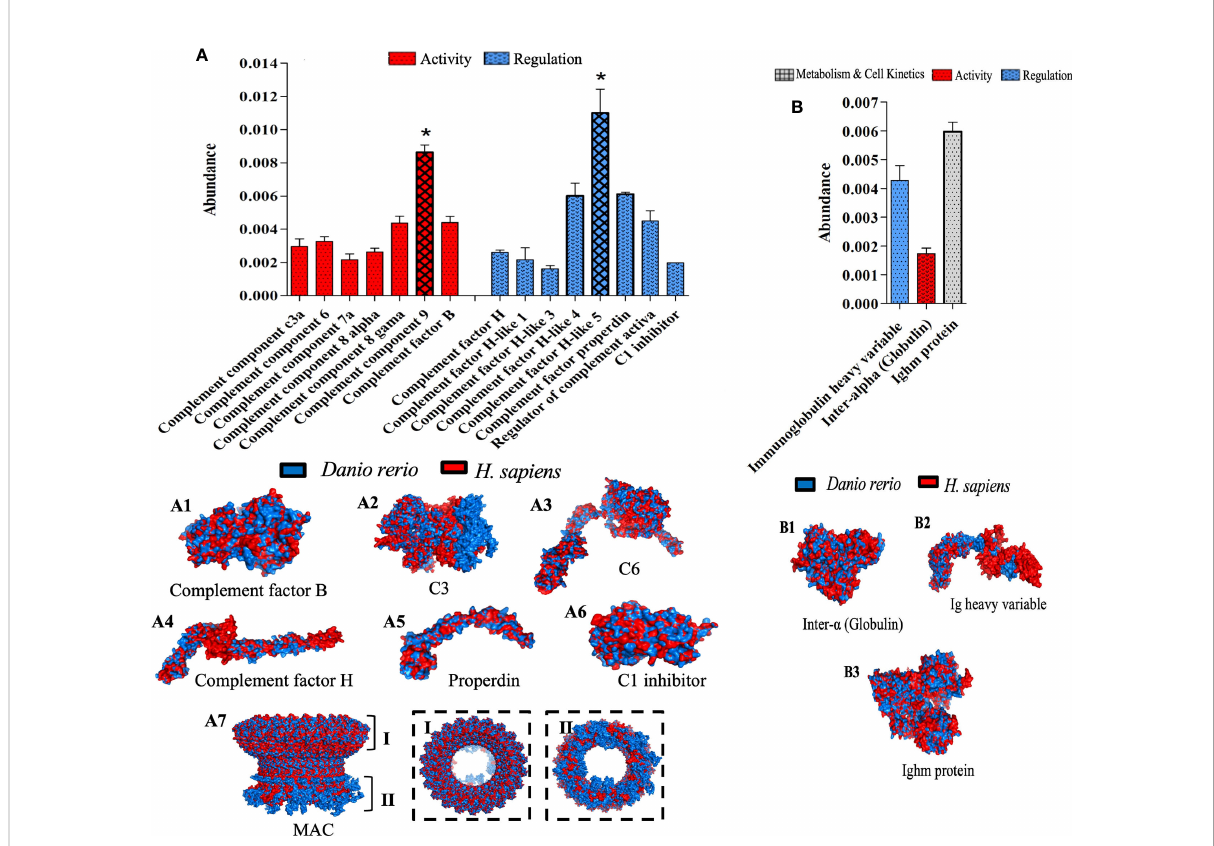
FIGURE 7 Top functional proteins linked to the complement system identi fi ed in zebra fi sh plasma after 4h of acute in fl ammation induction with l -CGN. (A) The abundance of the complement component proteins quanti fi ed by their activation and regulatory patterns. (A 1-7) Representations of the structural 3- D protein complement factors expressed in zebra fi sh (blue) plasma after the l -CGN-induced in fl ammation overlap with their predicted Homo sapiens (red) homologous structures. The overall architecture of the membrane attack complex (MAC). (A 7) Upper rim assembly of the barrel (I), and the cytoplasmic amphipathic region (II). (B) The activity, regulation, and metabolism & cell kinetics of natural antibodies affecting the classical complement pathway. (B 1-3) Exposed 3D zebra fi sh proteins contrasted with those of H. sapiens . The values in the graphs are expressed in relative abundance of the sample average (n = 4). The structural analysis of the proteins is described in the methodology. Abundance increases denoted by asterisks. Data are representative of two repeated trials in which all samples were run in triplicate (Student ’ s t test, p < 0.05). Results were analyzed using an unpaired t-test (p < 0.05) respective to the control value. Error bars indicate